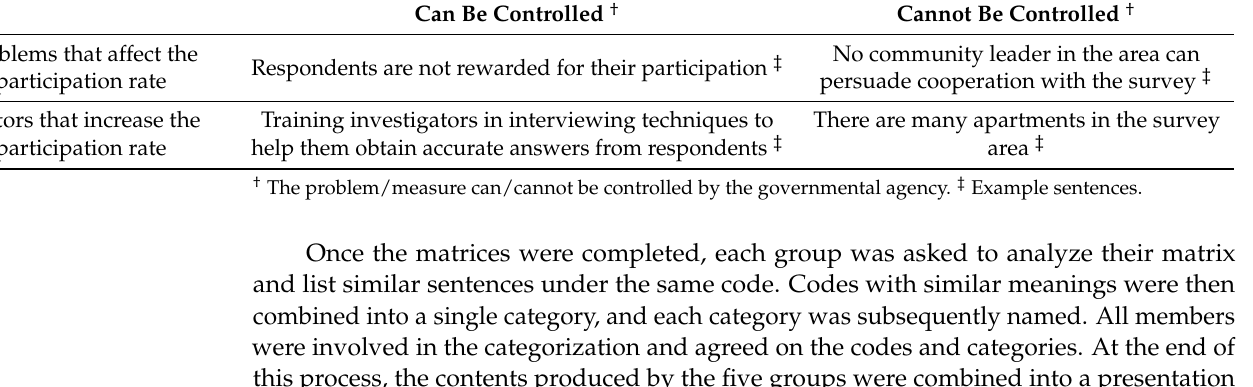
Table 2. Matrix of the topics addressed. Can Be Controlled